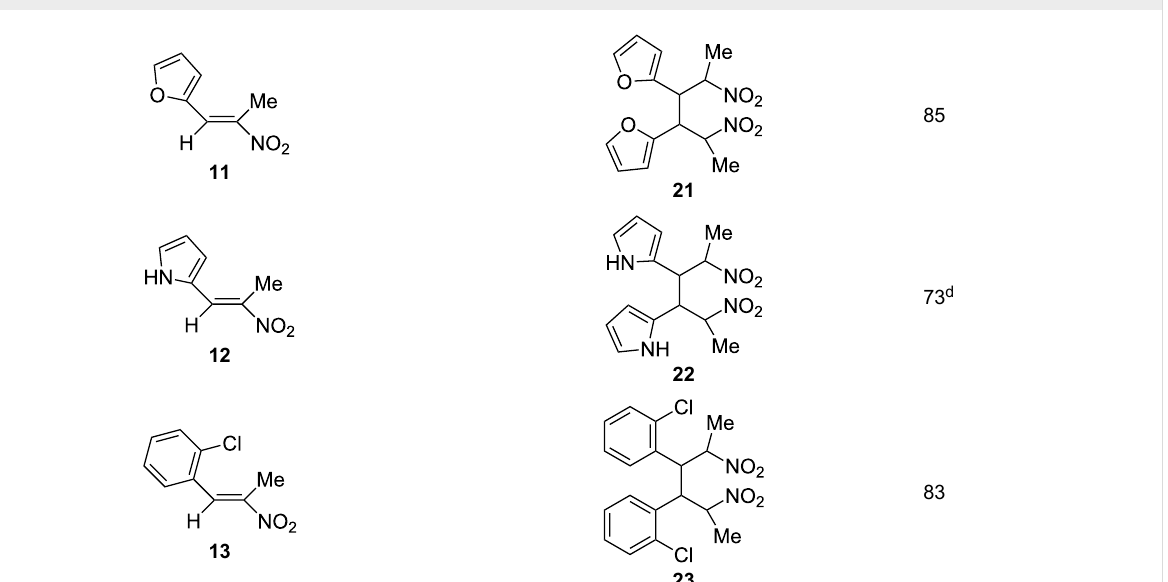
Table 4: Preparative hydrodimerization of nitroalkenes.